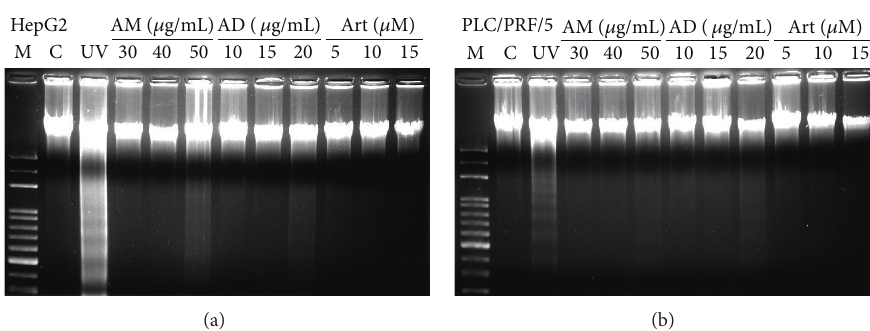
Figure 3: A. communis AM, AD, and Art did not induce apoptosis in HepG2 (a) and PLC/PRF/5 (b) cells. M: marker; C: cells treated